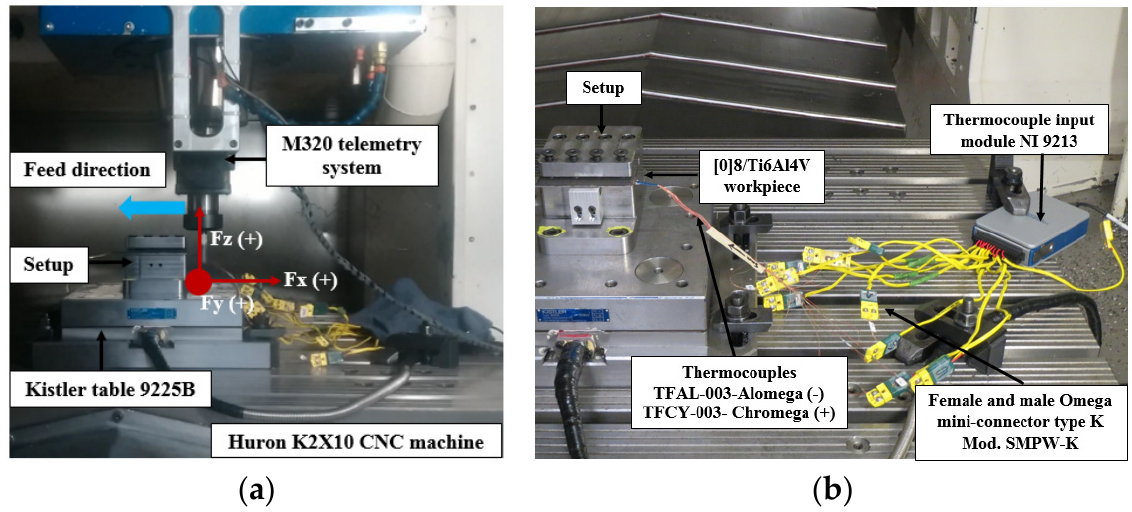
Figure 3. Experimental setup for the edge trimming of [0] 8 /Ti6Al4V coupons: ( a ) force and cutting tool temperature acqui- sition system; ( b ) thermocouples arrangement.